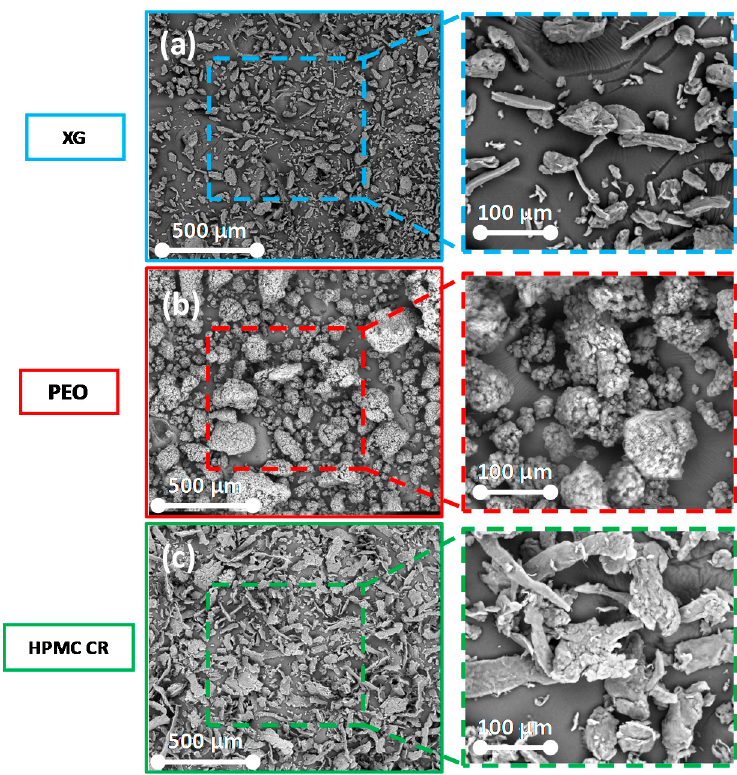
Figure 3 . Scanning electron micrographs of the polymers tested: ( a ) xanthan gum (XG), ( b ) polyethylene oxide (PEO), ( c ) hydroxypropyl methylcellulose (HPMC CR).